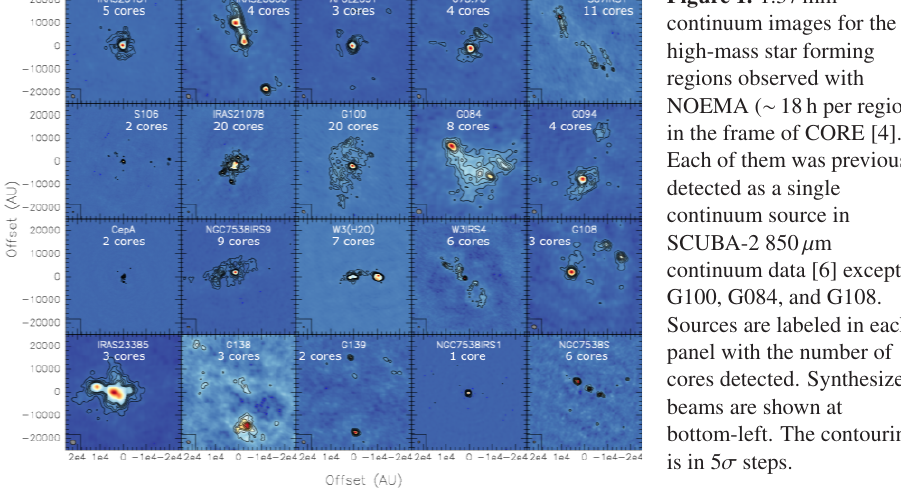
Figure 1. 1.37mm continuum images for the 20 high-mass star forming regions observed with NOEMA ( 18h per region) ∼ in the frame of CORE [4]. Each of them was previously detected as a single continuum source in SCUBA-2 850 µ m continuum data [6] except G100, G084, and G108. Sources are labeled in each panel with the number of cores detected. Synthesized beams are shown at bottom-left. The contouring is in 5 σ